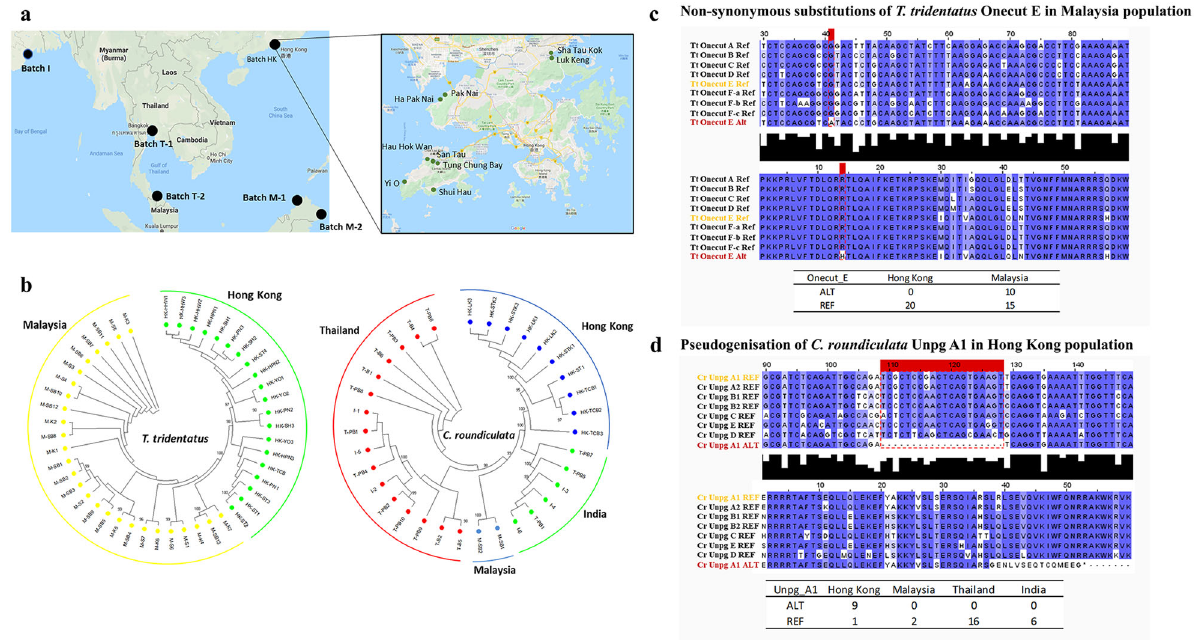
Fig. 5 Population genomics and evolutionary fates of paralogues. a Geographical distribution of C. roundicultata and T. tridentatus collected samples; b Phylogenetic trees of the collected samples. c Non-synonymous substitutions of T. tridentatus Onecut-E genes in individuals collected in Malaysia; d Pseudogenisation of C. roundiculata Unpg-A1 gene in individuals collected in Hong Kong